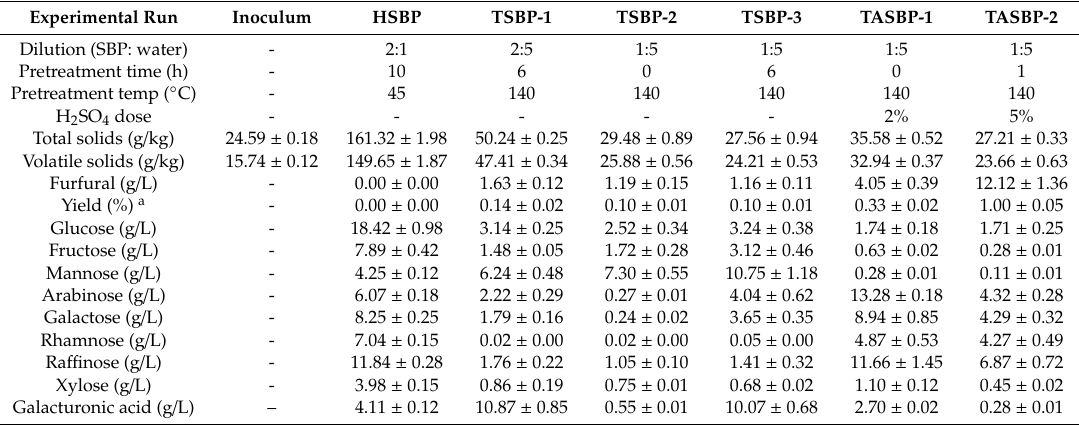
Table 1. Characteristic of substrates and parameters of pretreatment